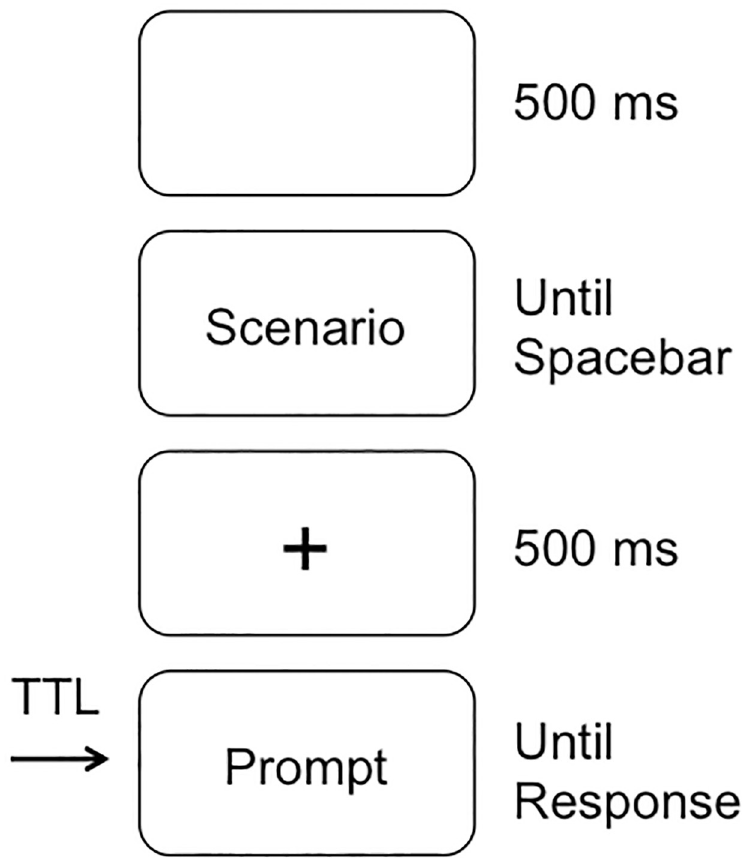
Fig 1. Sequence of events within a trial for the information security paradigm. The TTL pulse was aligned with onset of the Prompt, so that the response time and the ERP data are locked to onset of the prompt.